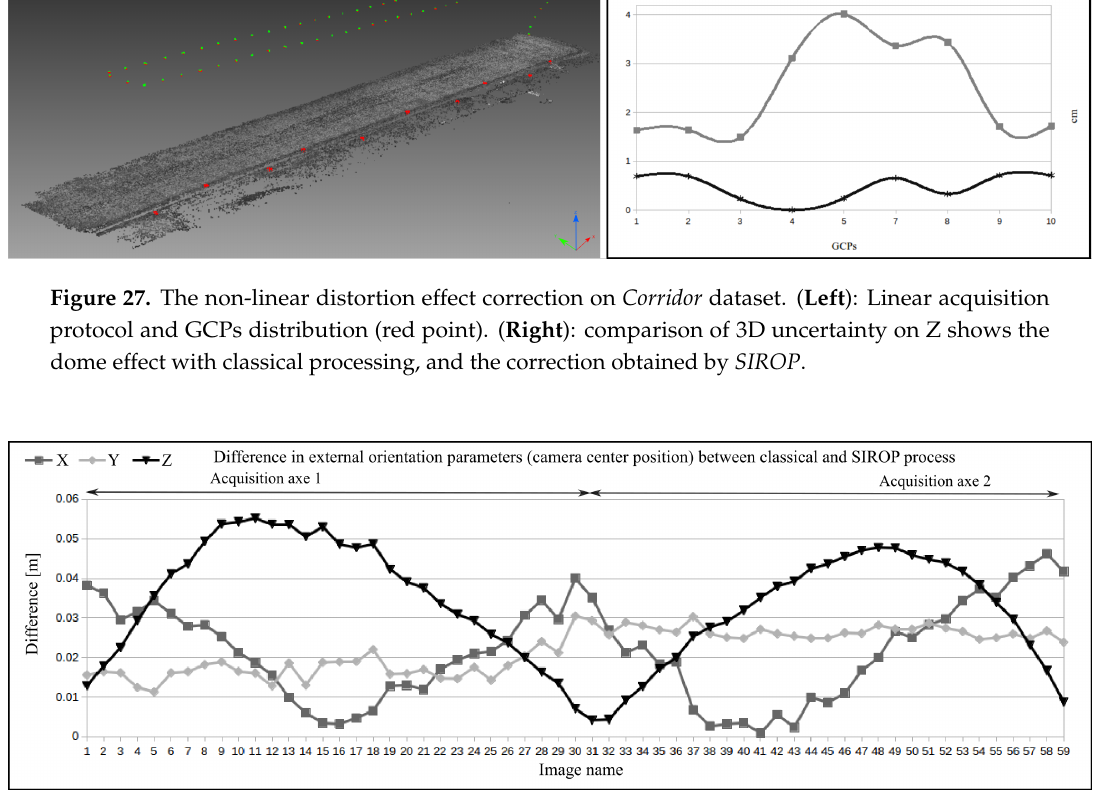
Figure 28. The difference of camera center positions in X,Y,Z of Corridor dataset after SIROP